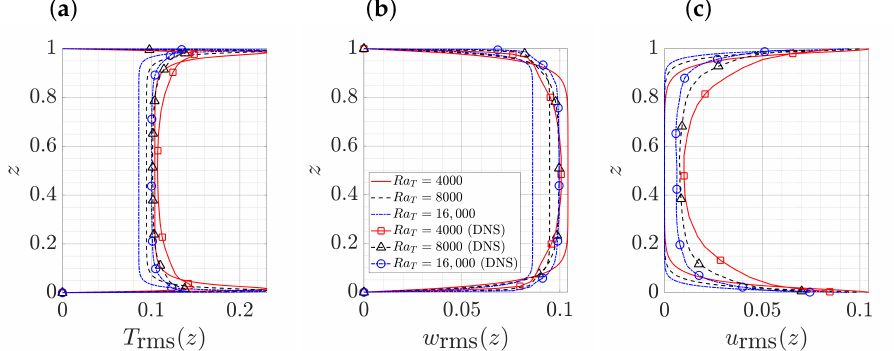
Figure 1. RMS profiles of ( a ) T rms ( z ) , ( b ) w rms ( z ) and ( c ) u rms ( z ) at Ra T = 4000, 8000, 16,000 associated with the 3D wavenumber k x = k y = 0.17 Ra 0.52 (lines) compared with DNS results (Figure 8b in [27]) (lines with markers). Legend for all three panels is provided in panel ( b